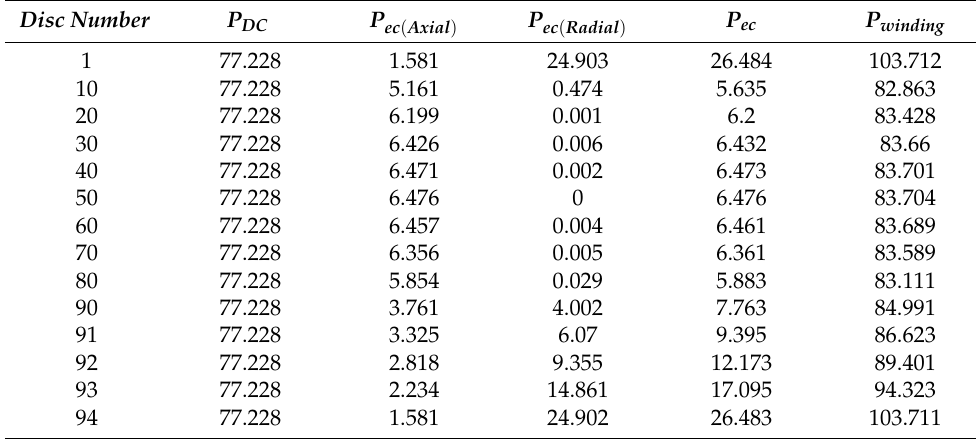
Table 5. Estimated losses per disc (W/m) on the LV winding—Case 2.